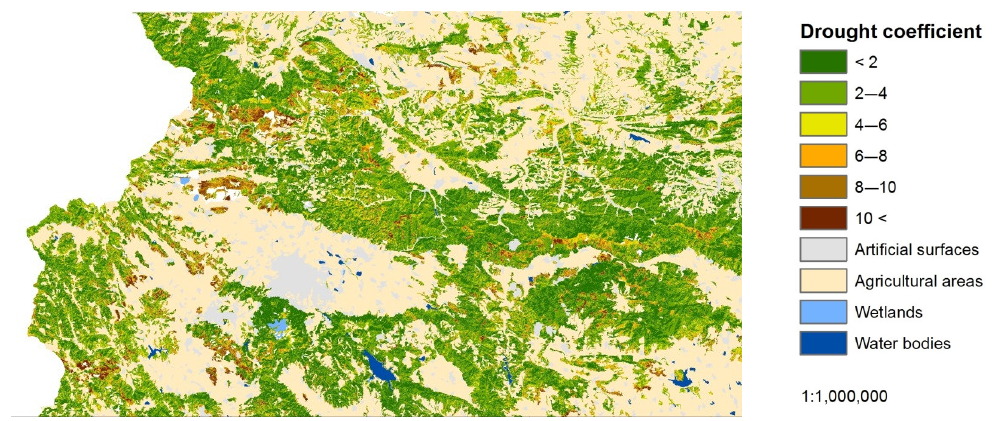
Figure 3. Distribution of DC in the middle of September.